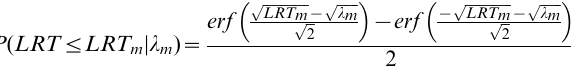
p l m ffiffi 2 p